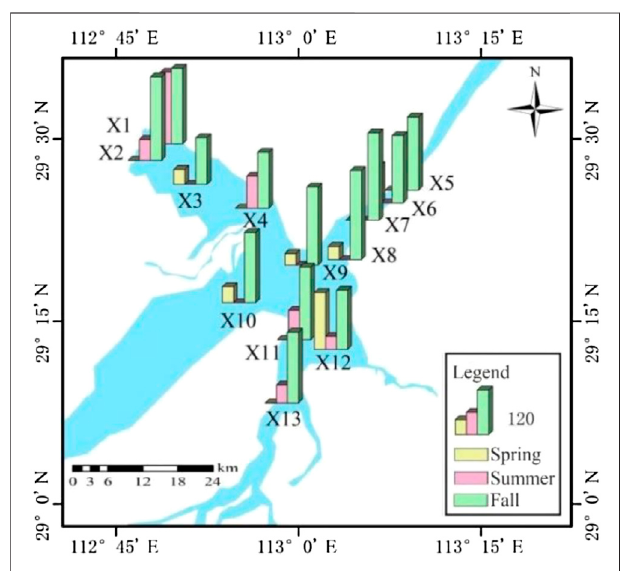
FIGURE 3 | Spatial distribution of antibiotic content in the sediment of East Dongting Lake in different